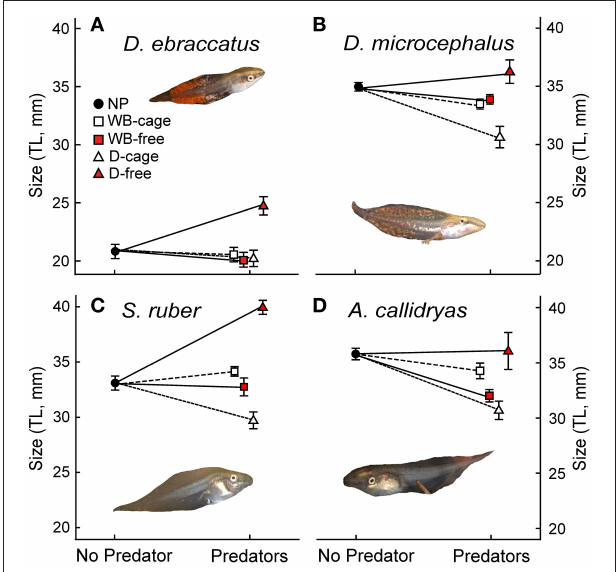
FIGURE 4 | Size at the end of the experiment (Total Length–TL- in mm, mean ± SE,) of: (A) D. ebraccatus ; (B) D. microcephalus ; (C) S. ruber; and (D) A. callidryas in a non-predatory environment (left, No Predator) and in each of the 4 predatory treatments (right) of this experiment. Treatments with water bugs (WB) are represented with squares and dragonflies (D) are represented with triangles. Open white symbols and dashed lines represent caged predators and red filled symbols represent free predators. All tadpole photos by